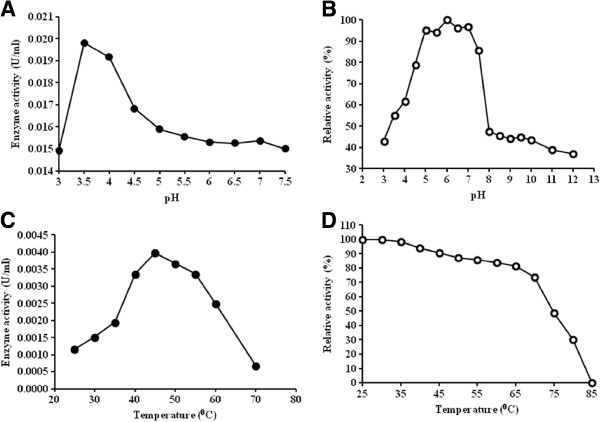
The optimum conditions for α-glucosidase activity of the partially purified rAciHBGase II–(His)6 enzyme. The optimal (A) pH and (C) temperature and the (B) pH or (D) thermal stability.